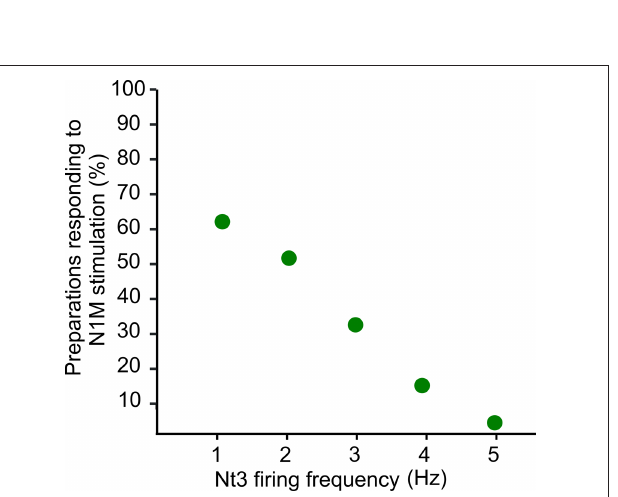
Figure 7 | Computer simulation of N3t firing frequency and preparation responsiveness. A constant depolarizing current was injected into the model N1M at different firing frequencies of the N3t. Whether the N1M (“preparation”) responded by generating a burst of action potentials to the depolarizing stimulus depended on the firing rate of the N3t. The preparations were more likely to respond when N3t is firing at its lowest rate (1 Hz) and responsiveness rapidly decreased as the firing rate is progressively increased to 5 Hz. Spike activity in the N1M in the biological network is a reliable indicator of activation of the whole CPG network and the feeding ingestive